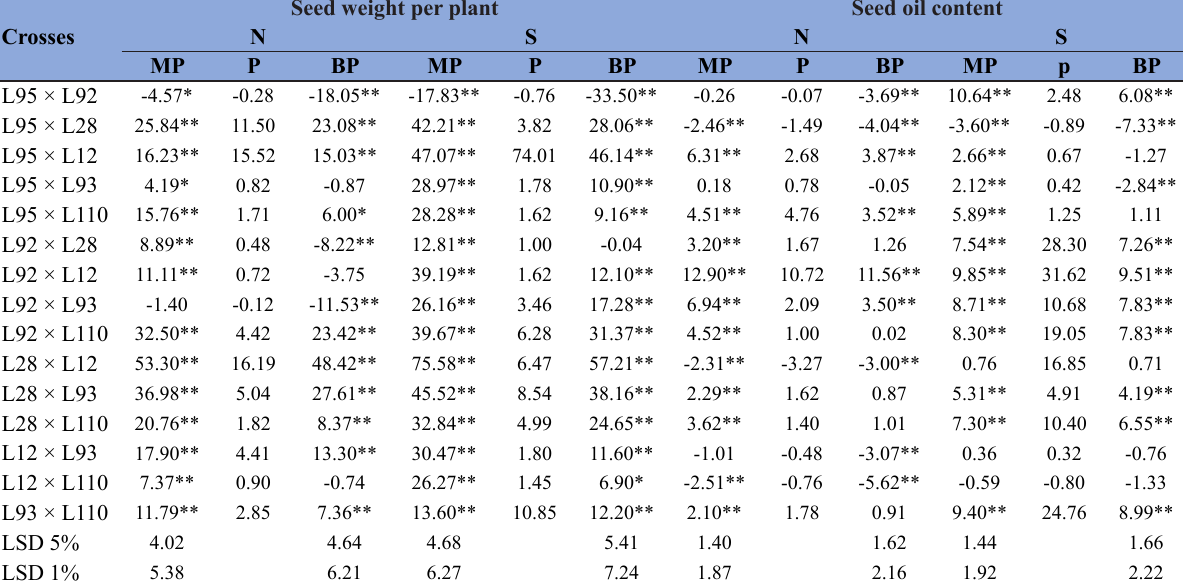
Table 10d. Relative heterosis (MP) and heterbeltiosis (BP) as well as potence ratio (P) of 15 F per plant and seed oil content under normal irrigation (N) and water stress conditions (S) in 2019